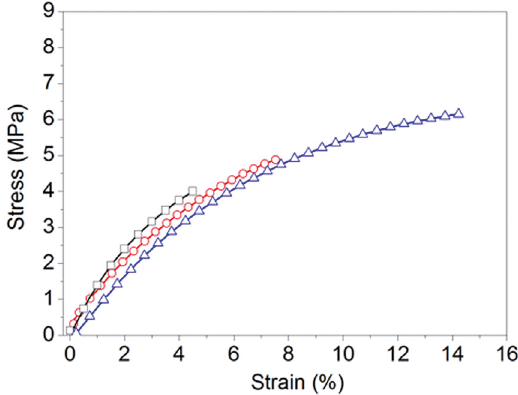
Figure 7. Stress versus strain curves for PVA/CS mats at 70:30 (M3, squares), 75:25 (M4, circles) and 85:15 (M6, triangles) compositions. gradually as the temperature was increased. The amount of CS in the mats had an expressive influence on E’